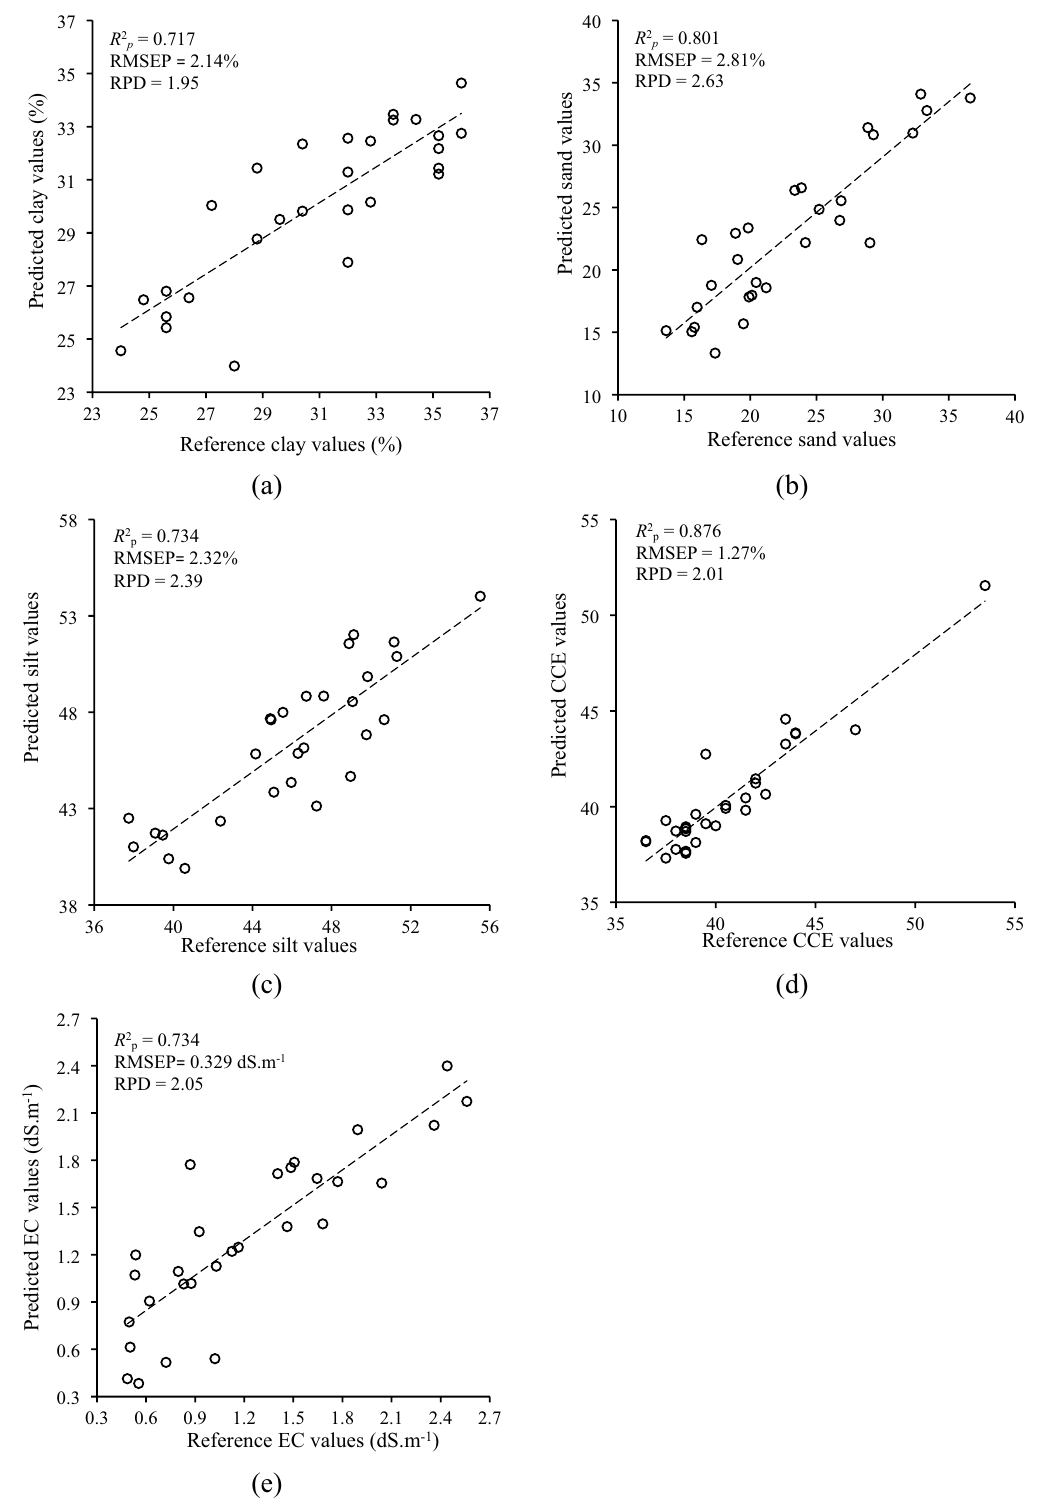
Figure 2. Reference versus estimated values obtained by the best PLS models in predicting ( a ) clay and ( b ) sand using the combination data of both instruments, and ( c ) silt, ( d ) calcium carbonate equivalent (CCE), and ( e ) electrical conductivity (EC) using spectral data of InGaAs